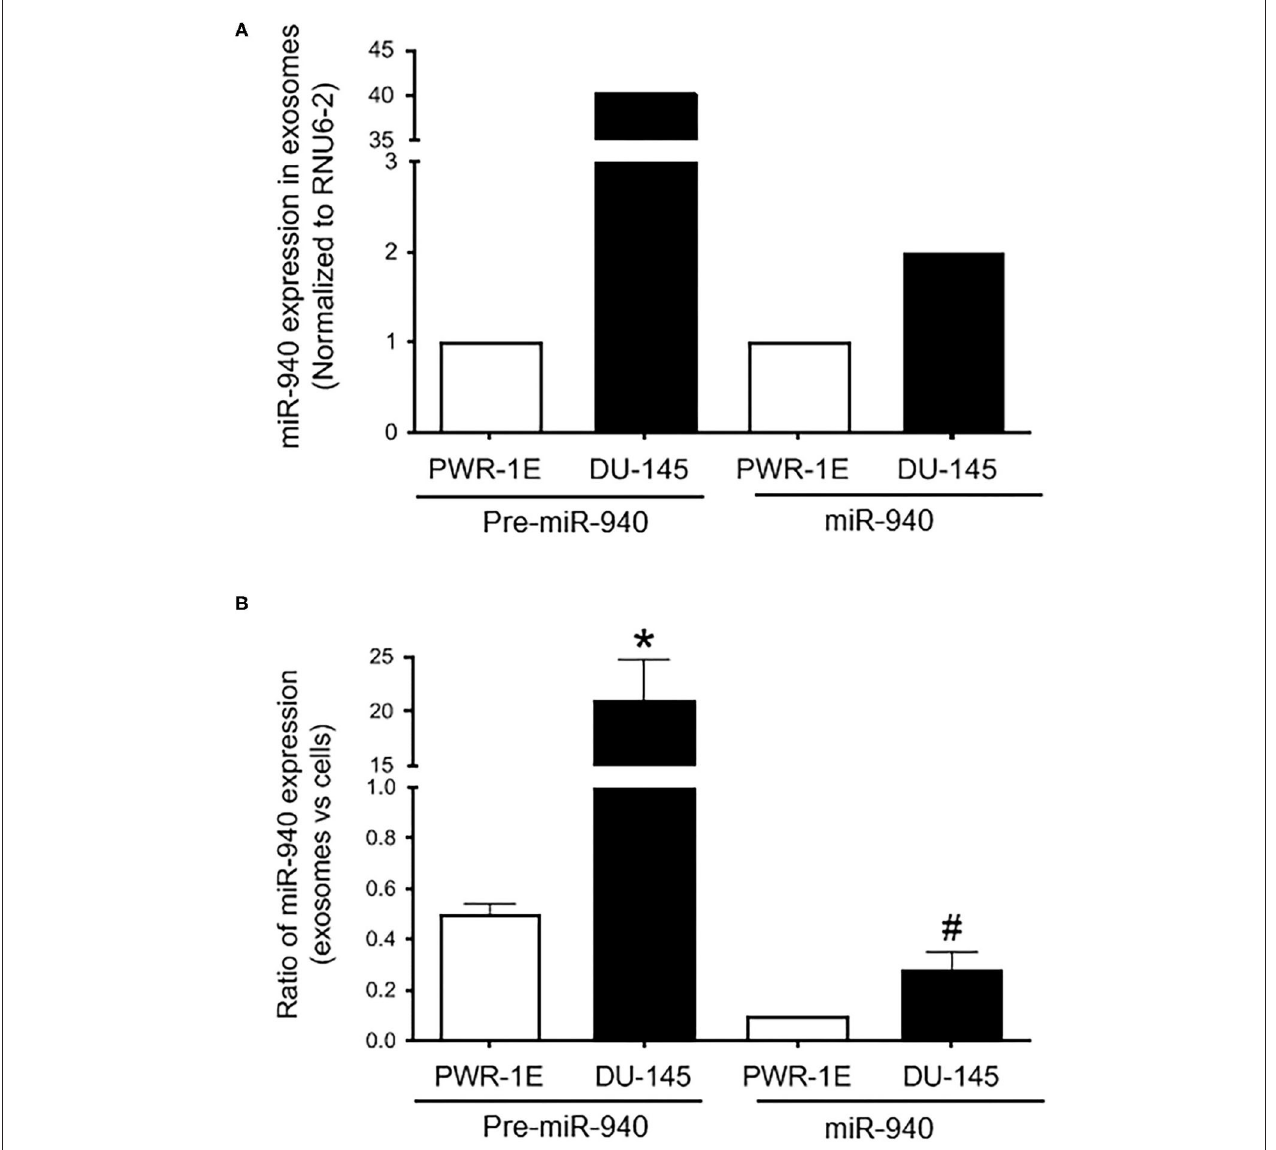
FIGURE 1 | Expression of miR-940 in cell culture supernatant. (A) Higher levels of both precursor (Pre-miR-940) and mature (miR-940) miRNA are detected in the exosomes derived from the cell culture supernatant of the DU-145 cancer cells compared to the normal PWR-1E cells as measured by qPCR (normalized to RNU6-2). (B) Ratio of miR-940 from the secreted exosomes to miR-940 within the cells, as determined by qPCR, is plotted as a fold change in the normal and cancer cells. The experiment was repeated two independent times. # p- value ≤ 0.1; * p -value ≤ 0.05.